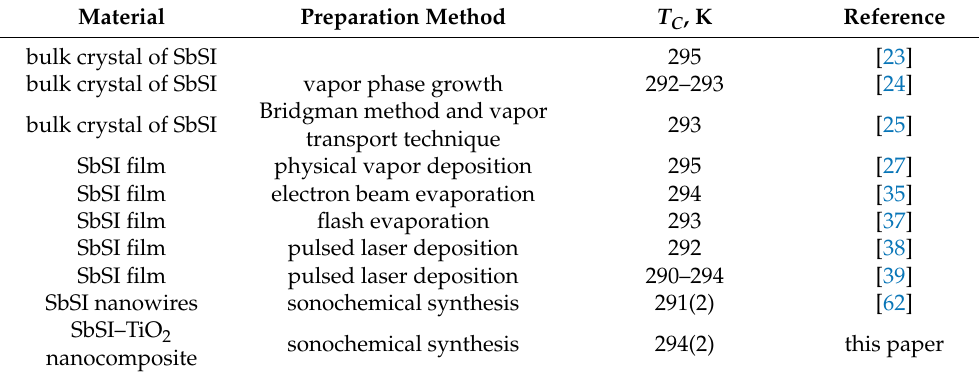
Figure 4. The temperature dependence of the electric current registered under a constant bias voltage of 0.1 V ( a ) and the Arrhenius plot electrical conductance of the SbSI–TiO 2 nanocomposite ( b ). The solid red and blue lines in ( b ) represent the best fitted theoretical dependence (2) in the paraelectric and ferroelectric phases, respectively. The green, dashed line indicates the reciprocal value of the determined Curie temperature. The values of the fitted parameters of Equation (2) are given in the text. Table 2. A comparison of the determined Curie temperature of the SbSI–TiO 2 nanocomposite with literature data for